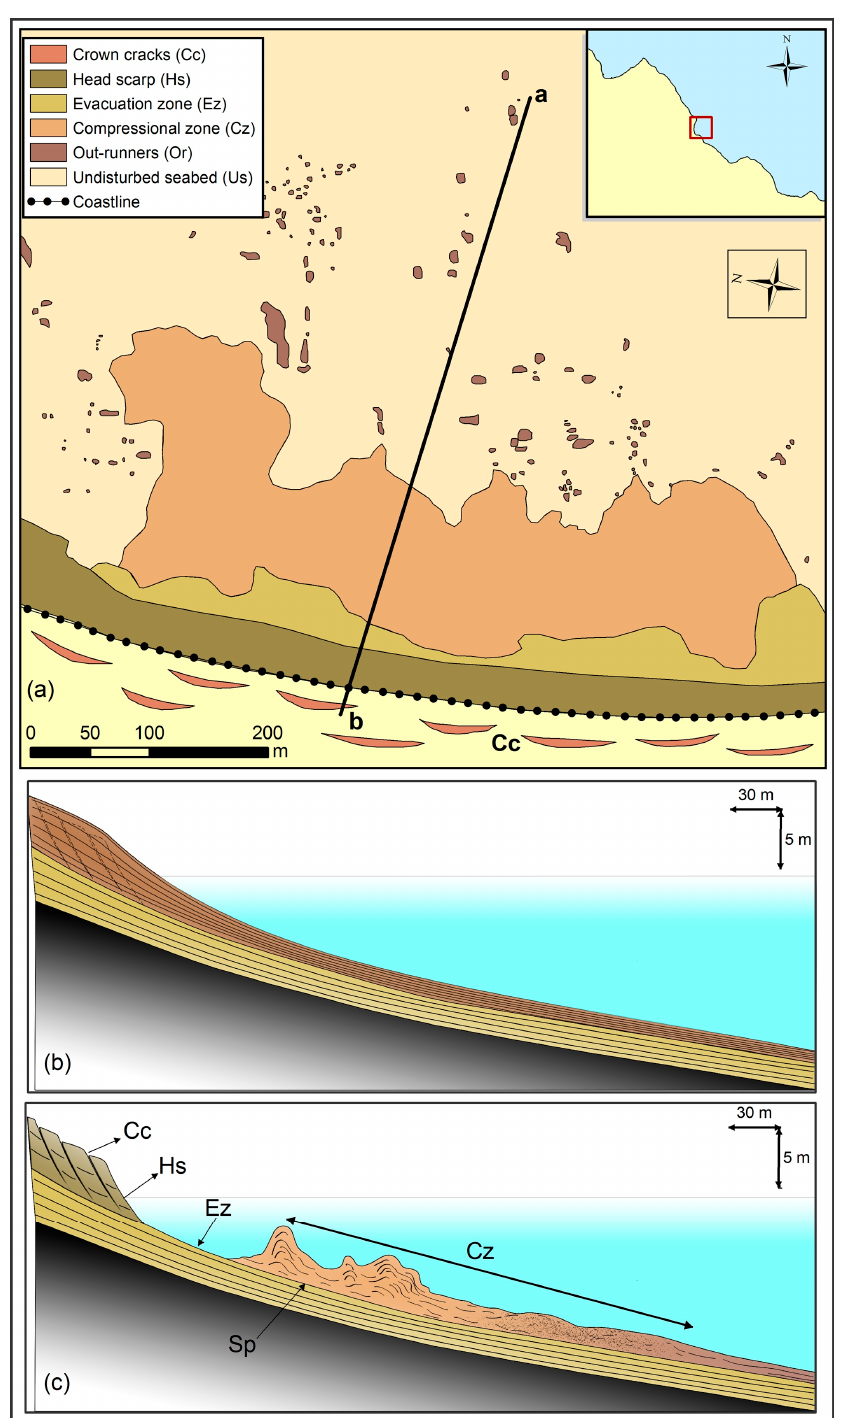
Figure 5. ( a ) Simplified schematic map of the coastal landslide showing the above mentioned features as interpreted from the sonar mosaic and seismic profiles; Sketch drawing showing a seabed profile before ( b ) and after ( c) the 1995 earthquake. (Cc): Crown cracks, (Hs): Head scarp, (Ez): Evacuation zone, (Cz): compressional zone, (Sp): Slip plane. For the location of the profile ab see Figure